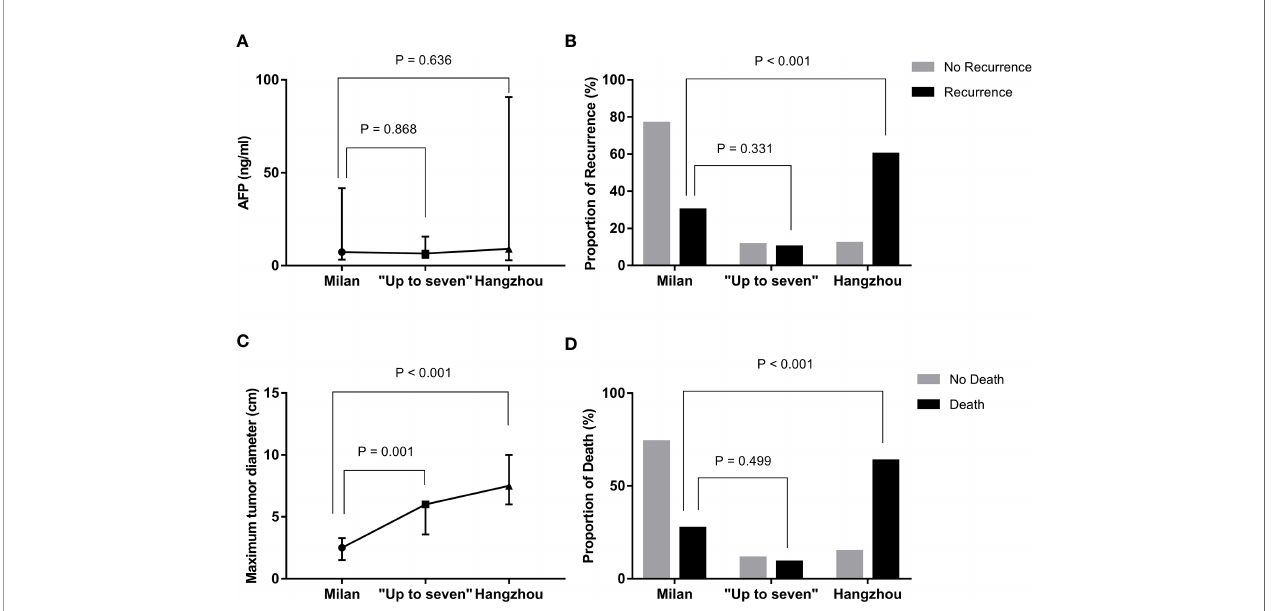
FIGURE 1 | Differences in recurrence, death, and tumor characteristics in patients with HCC under distinctive liver transplant criteria. (A) compared with Milan criteria, patients who met “ Up-to-seven ” and Hangzhou criteria had similar AFP concentrations ( p = 0.636). (B) compared with Milan criteria, patients who met “ Up- to-seven ” and Hangzhou criteria had a higher prevalence of HCC recurrence ( p = 0.001). (C) compared with Milan criteria, patients who met “ Up-to-seven ” and Hangzhou criteria had longer tumor diameter ( p < 0.001). (D) compared with Milan criteria, patients who met “ Up-to-seven ” and Hangzhou criteria had a higher prevalence of HCC-related death ( p < 0.001). HCC, hepatocellular carcinoma; AFP,